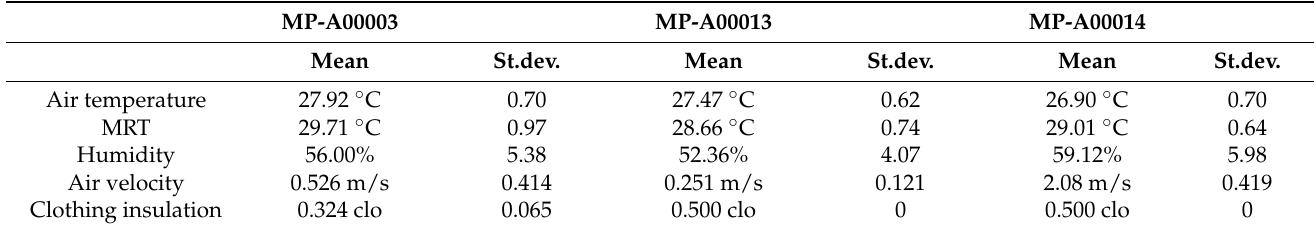
Table 7. Main parameters for the three distinct platforms in